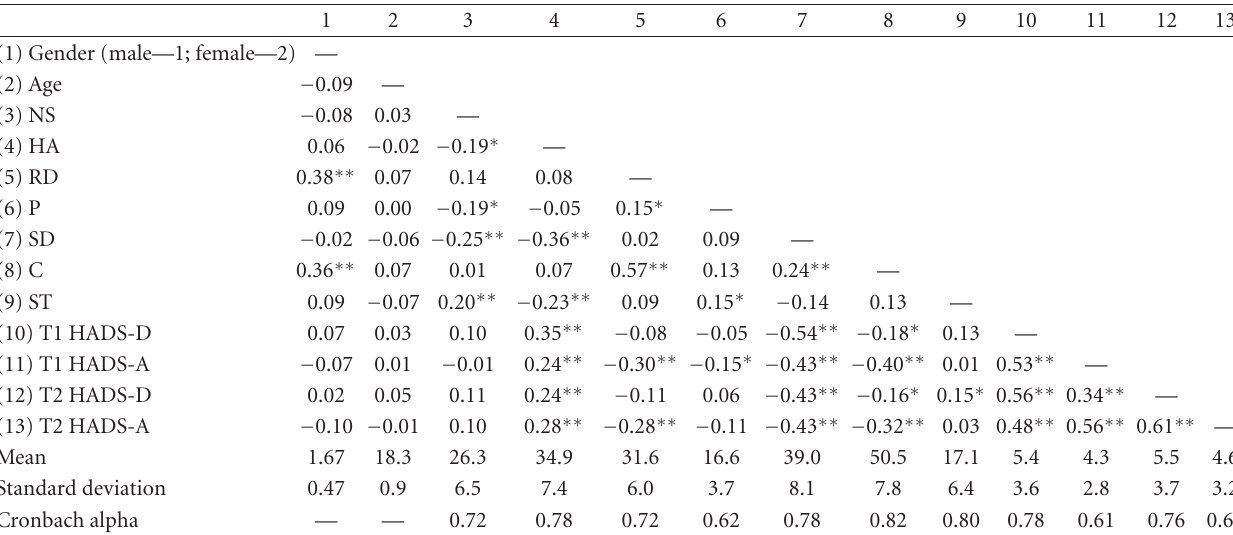
Table 1: Correlations between variables used in the path analysis ( N =